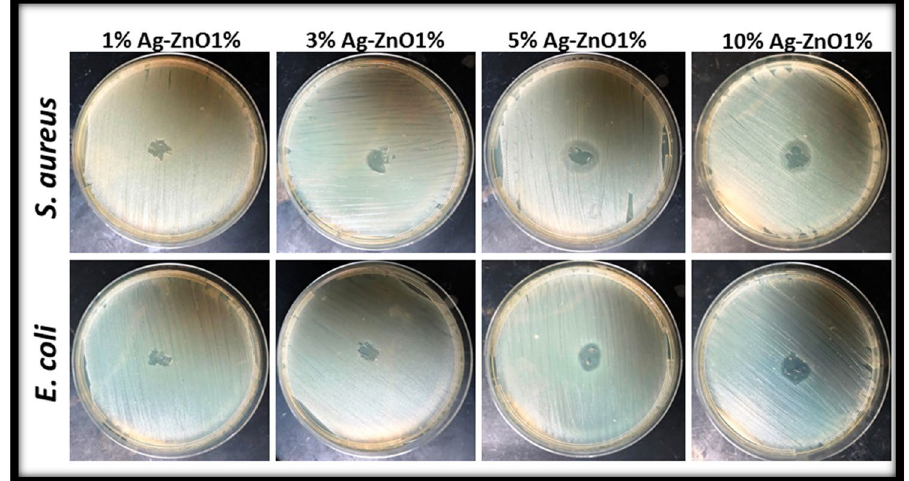
Figure 8. The surface bacterial growth inhibition by the applied PHBV/Ag–ZnO (1,3,5,10%) bionanocomposites against the S. aureus and E. coli as a bacterial test